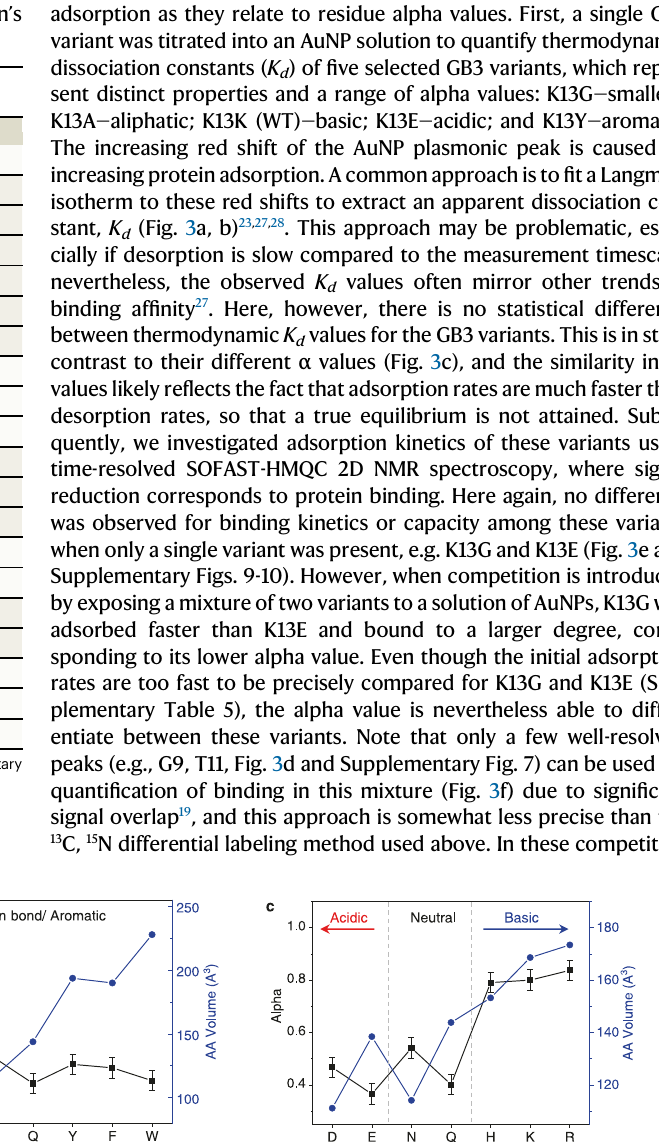
20GB3variants. The graycurve isa polynomial fi t to guide the eye. Data points of acidic,basicresiduesandK13Marehighlightedinred,blueandgreen,respectively. R 2 iscalculatedfromPearson ’ scorrelationcoef fi cientusingOriginProSoftware.All error bars are an averaged 95% con fi dence interval error as described in the Sup- plementary Information ( n =3 independent experiments).